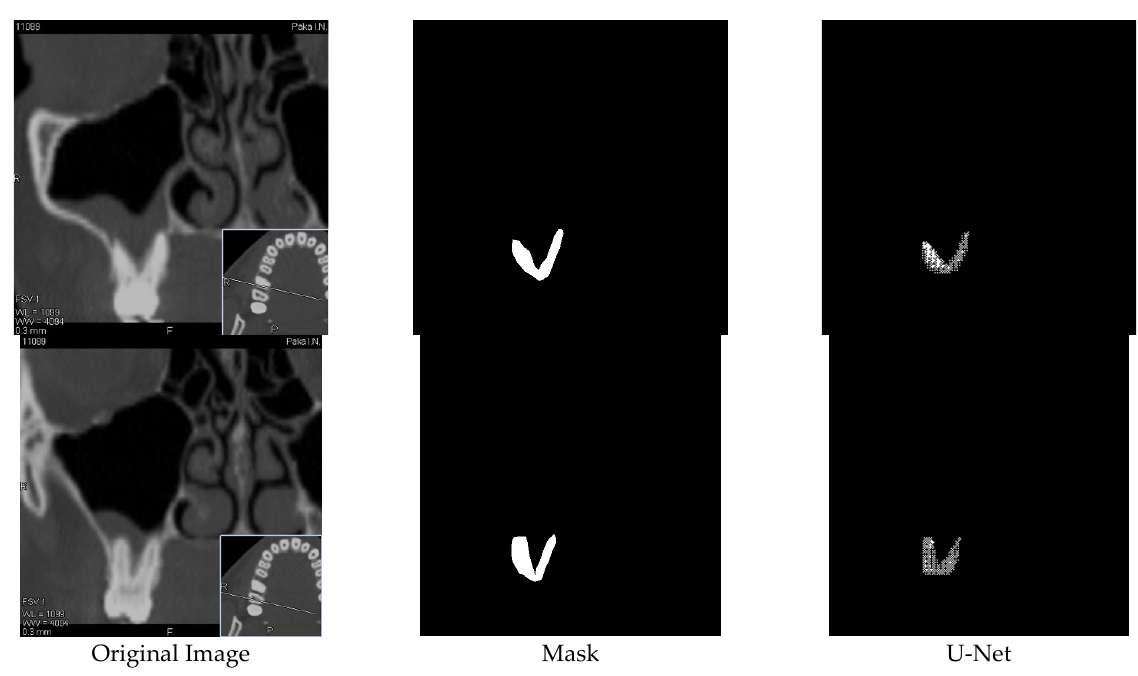
Figure 5. Segmentation results.